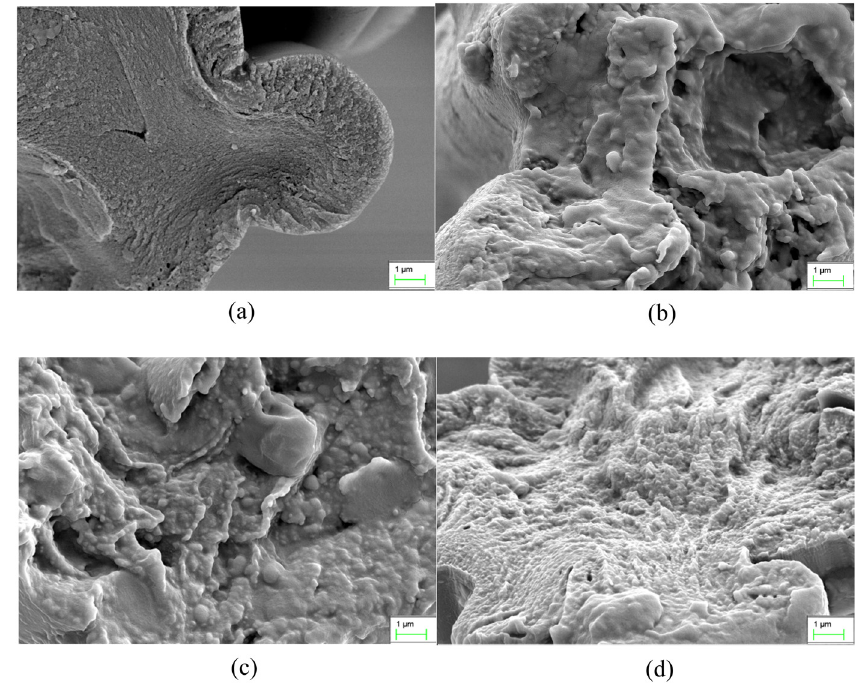
Figure 4: Cross - section of the fi ber under di ff erent conditions. The magni fi cation of the image is 20k times. ( a ) Viscose fi ber, P = 0. ( b ) Spun - dyed viscose fi ber, P = 76.96. ( c ) Spun - dyed fi ber, P = 153.92. ( d ) Spun - dyed fi ber, P = 307.84.